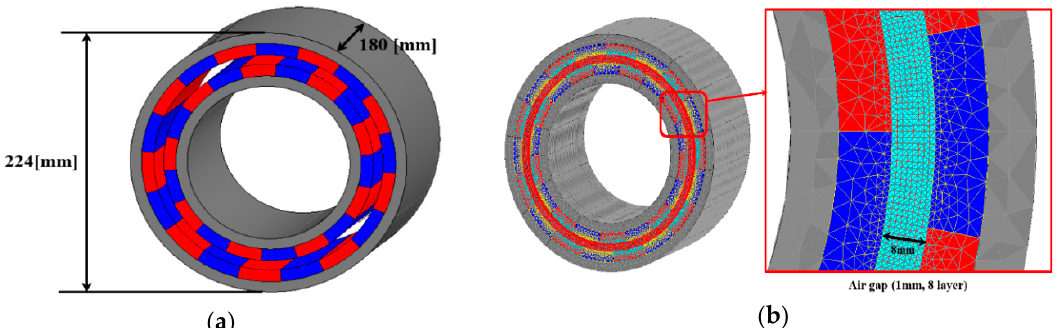
Figure 14. The 10 kW-magnetic coupling design ( a ) shows the outer diameter and length of the magnetic coupler; ( b ) shows the mesh of the coupler and air gap. The air gap is made of eight layers of 1 mm thickness.